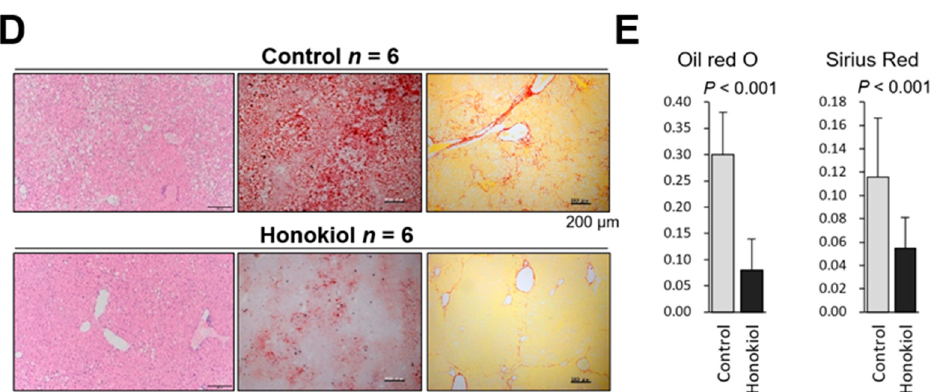
Figure 1. Honokiol (HNK) treatment attenuates hepatocellular carcinoma (HCC) development in major urinary protein (MUP)-urokinase type plasminogen activator (uPA) transgenic mice. ( A ) Protocol for honokiol treatment in MUP-uPA transgenic mice fed a high-fat diet (HFD). Then, six week-old male mice fed an HFD for 26 weeks were treated with vehicle control or HNK (10 mg/kg, intraperitoneally (three times/week) for another 8 weeks (32–40 weeks of age). Tumor development was analyzed at 40 weeks. For the non-alcoholic steatohepatitis (NASH) analysis, 6-week-old male mice fed an HFD for 6 weeks were treated with vehicle or HNK for 8 weeks (12–20 weeks of age). During honokiol treatment, the HFD feeding regimen was continued. ( B ) Gross morphology of livers with HCC and typical HCC histology in mice of the MUP-HFD model. ( C ) Maximal tumor size and tumor numbers in MUP-HFD mice treated with vehicle or honokiol. Tumor development was analyzed 2–4 days after the final honokiol injection. Results are presented as the median with interquartile ranges. ( D ) Liver sections of MUP-HFD mice were analyzed at 20 weeks of age after treatment with vehicle or honokiol for the last 8 weeks of NASH development. Liver histology, lipid accumulation, and fibrosis were analyzed by staining liver sections with hematoxylin and eosin, Oil red O, and Sirius Red, respectively. ( E ) The positive areas were quantified using ImageJ software and presented as bar graphs. Results are presented as the mean ± SD.